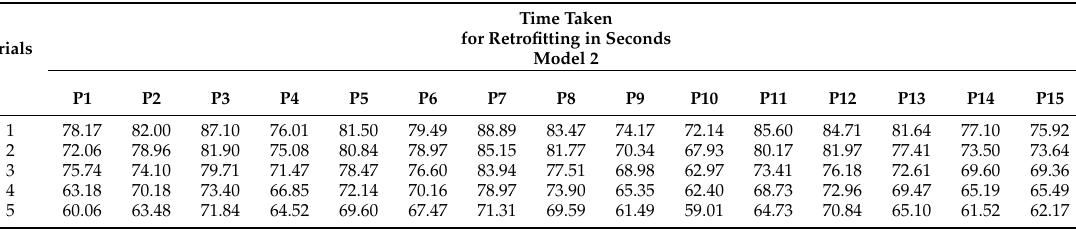
Table 4. Task 2: Participants’ time taken for retrofitting Model